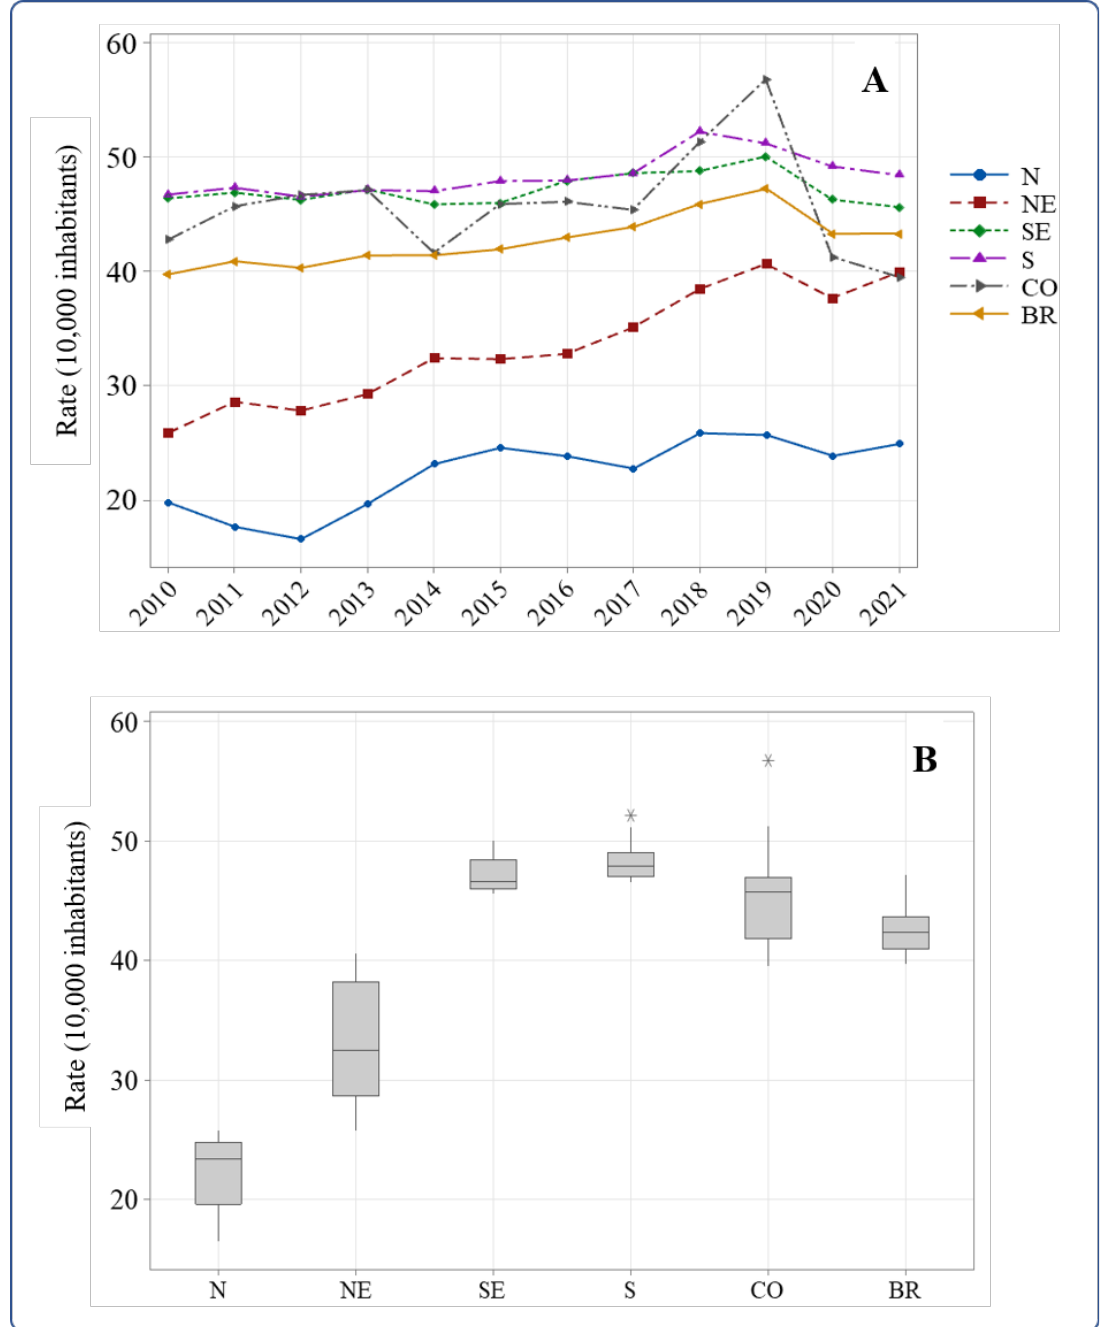
Figure 1. Temporal distribution ( A ) and box plot for median and quartiles ( B ) of the age-adjusted fall-related hospitalization rate in elderly people in Brazil and its regions, 2010 to 2021. * Outlier. Regions: N—North; NE—Northeast; SE—Southeast; S—South; CO—Center-West; BR—Brazil. Source: Brazil [13].